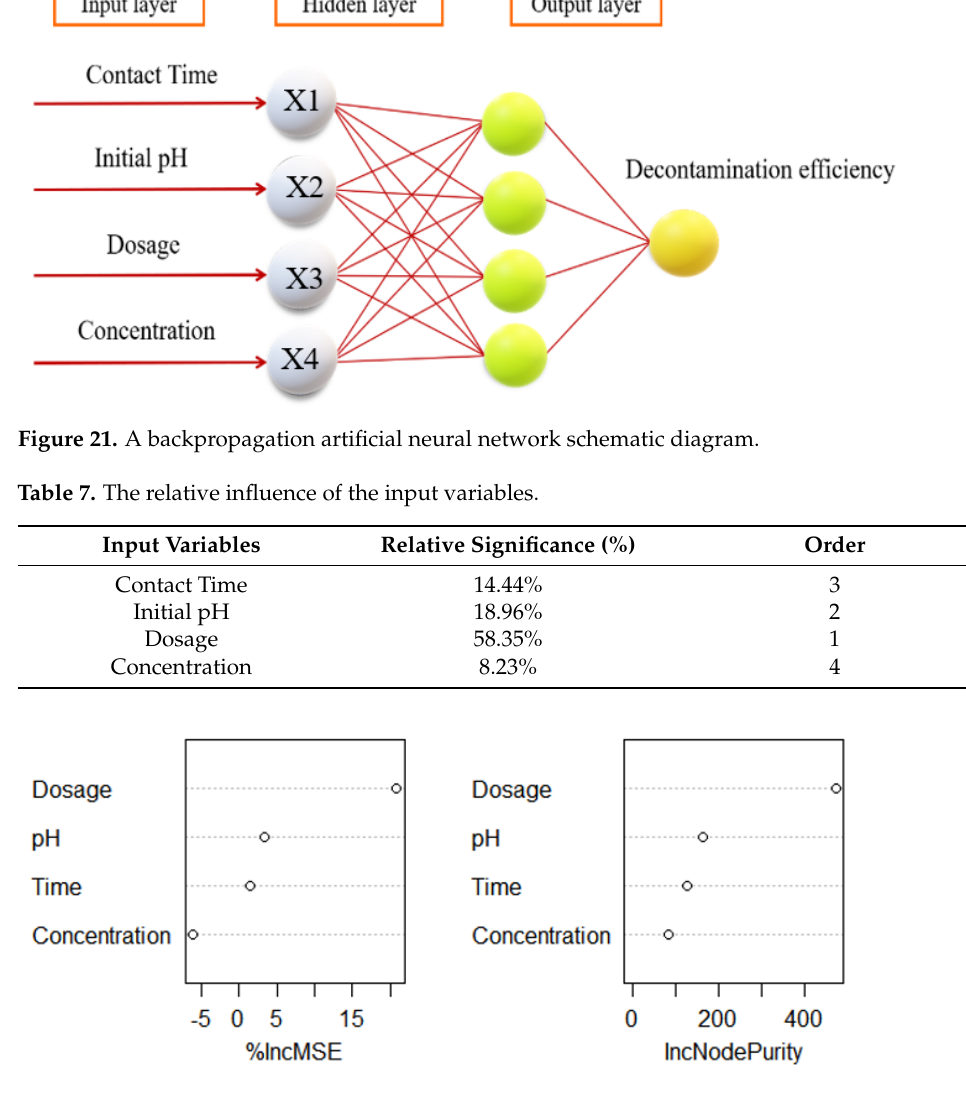
Figure 22. The relative impact of the input variables obtained by R-studio.